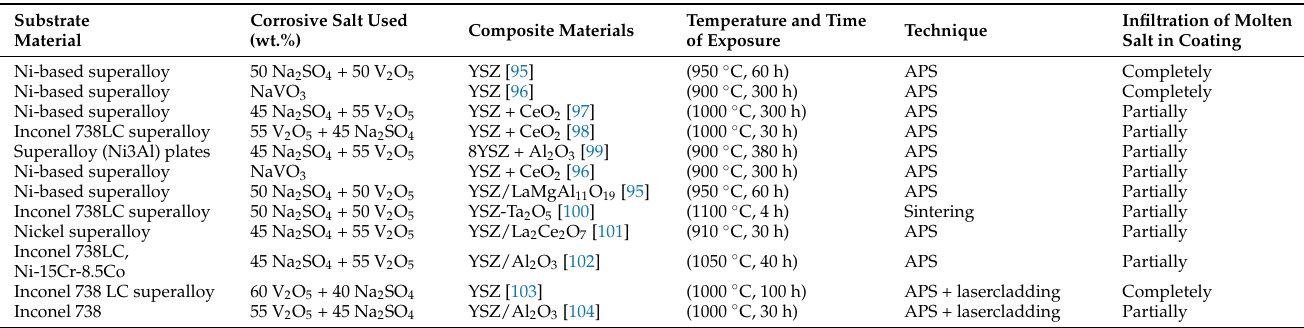
Table 2. Hot corrosion behavior of TBC-based YSZ coatings in the presence of corrosive salts and infiltration mode.